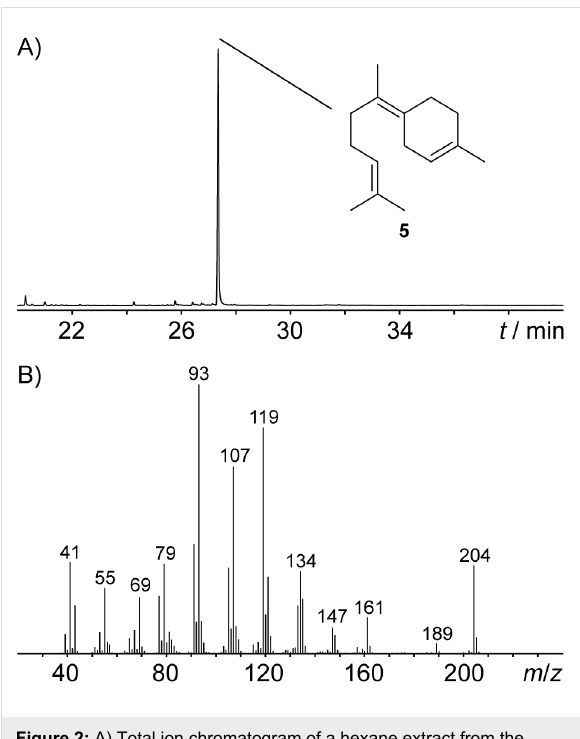
Figure 2: A) Total ion chromatogram of a hexane extract from the incubation of FPP with BbS and B) EI mass spectrum of the main product identified as ( Z )- γ -bisabolene ( 5